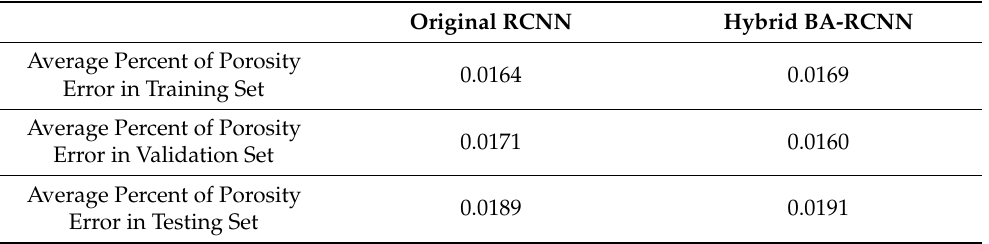
Table 5. Average percent of porosity error (first version).